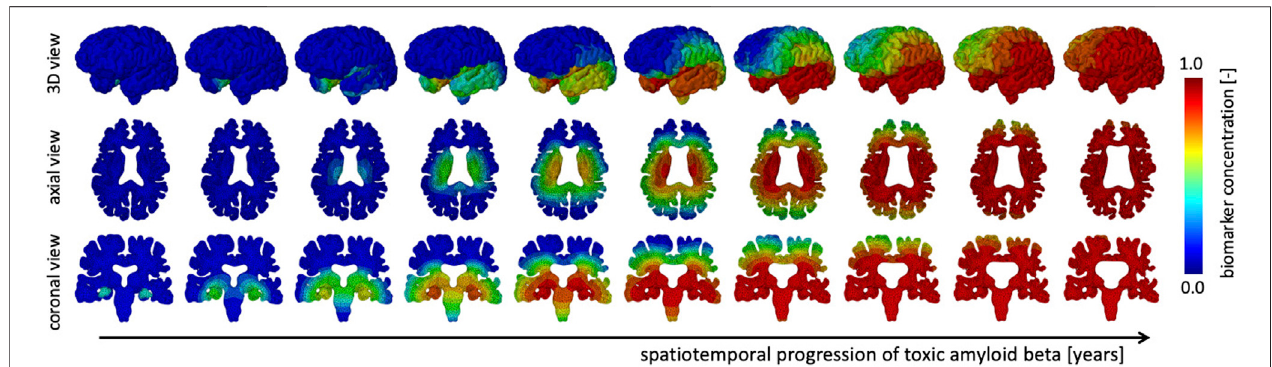
FIGURE 3 | The spatiotemporal spreading behavior of our biomarker for neurodegenerative disease is governed by a reaction-diffusion equation. We seed the biomarker in the hippocampus and observe a gradual in fi ltration of the whole brain. The temporal lobe is affected fi rst, followed by the occipital, then parietal, and fi nally the frontal lobes, see 3D view. Moreover, we observe an early affect on deep gray and white matter structures before diffusing outward into the cortical layer, see axial view. In our current version of the model, we prescribe equal diffusion in gray and white matter tissue, which is re fl ected in the diffuse spreading of the biomarker